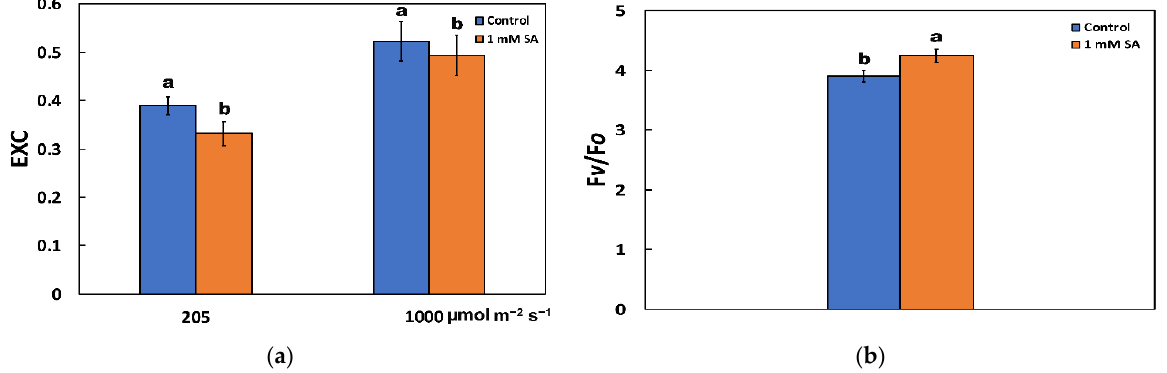
Figure 3. The relative excess energy at PSII (EXC), estimated at 205 and 1000 μmol photons m − 2 s − 1 actinic light (AL) intensity ( a ); and the efficiency of the oxygen evolving complex (OEC) on the donor side of PSII (F v /F o ) ( b ); in tomato leaves after 72 h of foliar spray by either distilled water (control) or 1 mM salicylic acid (SA). Error bars are standard deviations ( n = 4). Columns with different lowercase letters are statistically different ( p < 0.05).